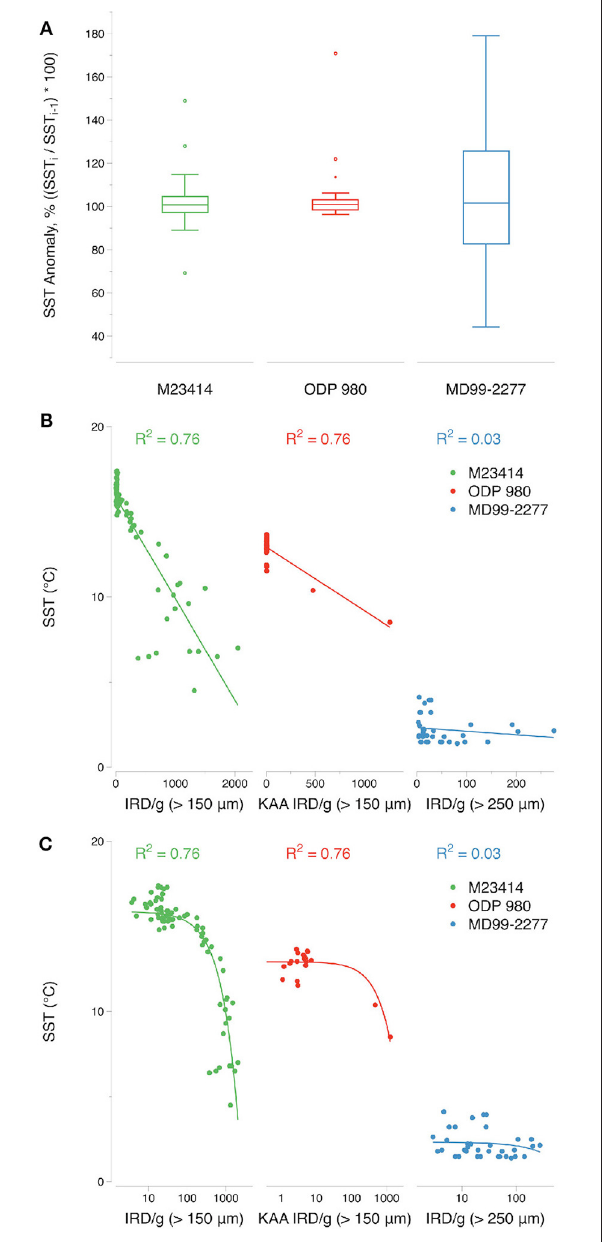
FIGURE 5 | Relationship between SST and IRD (A) SST anomalies expressed as percentage change from previous value from 419 to 390 ka. (B) Relationship between SST (McManus et al., 1999; Kandiano and Bauch, 2007; Kandiano et al., 2016) and IRD (McManus et al., 1999; Helmke et al., 2003; Kandiano and Bauch, 2007; Kandiano et al., 2012) on a linear scale and (C) logarithmic scale. Data from ODP 980 are ka-averaged (“KAA”) to align IRD and SST